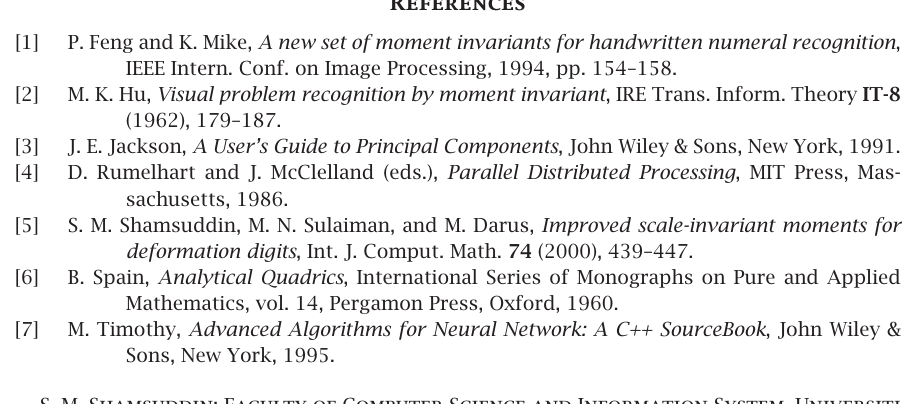
Figure A.1 . Samples of handwritten